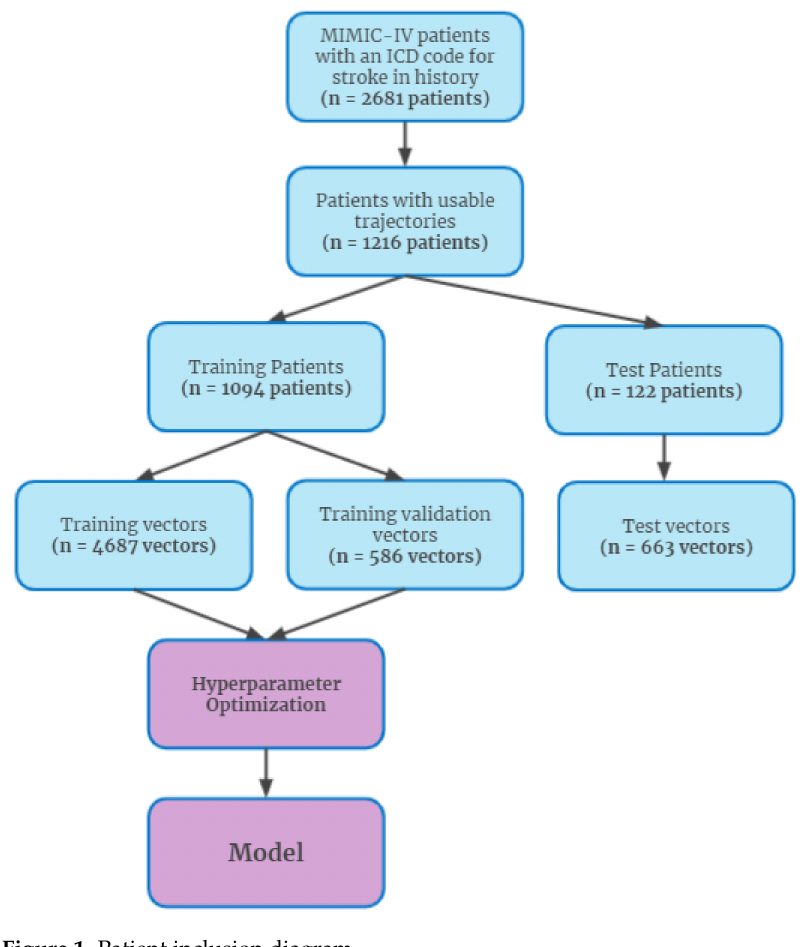
Figure 1. Patient inclusion diagram.